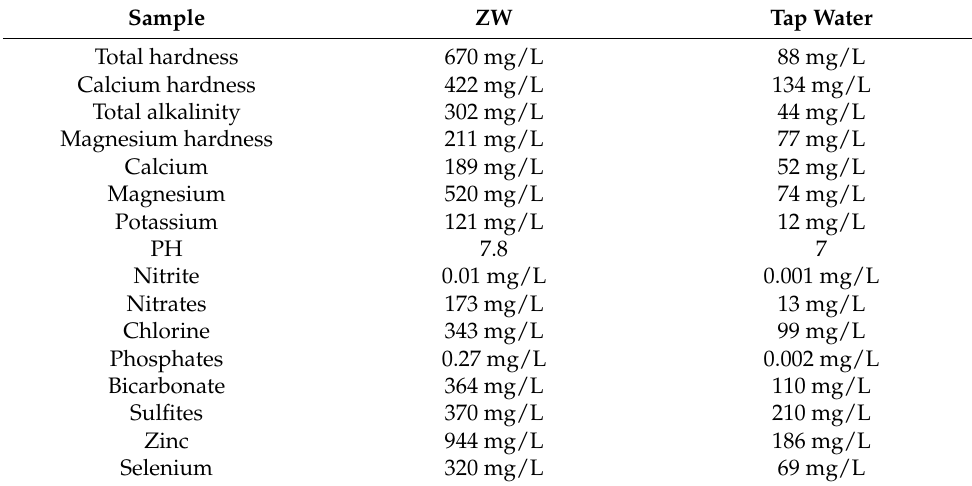
Table 4. Physical and chemical analysis of Zamzam